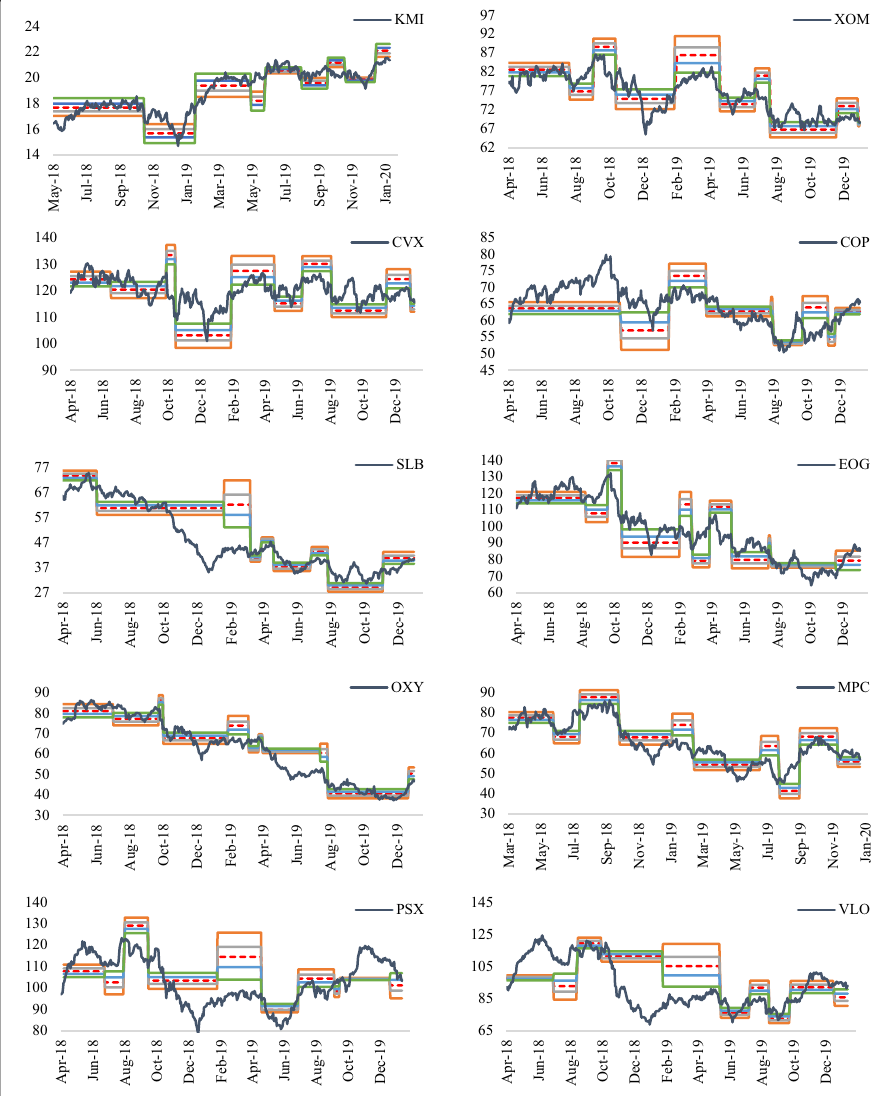
than during uptrends. There were more violations for the ten energy stocks during downtrends than uptrends for seven of the stocks, except for KMI, MPC, and VLO. Energy cryptos followed the same trend, i.e., price violations of the retracement lev- els for all cryptos during periods of downtrends. More importantly, during uptrends, the highest number of violations occurred at the 61.8% retracement level. In contrast, during downtrends, numerous violations occurred at the 23.6% level. These findings suggest that while the Fibonacci retracement tool captured most of the downward movements in energy stock and crypto prices during an uptrend, price increases dur- ing downtrends were omitted. Noticeably, constituents with more price violations at a